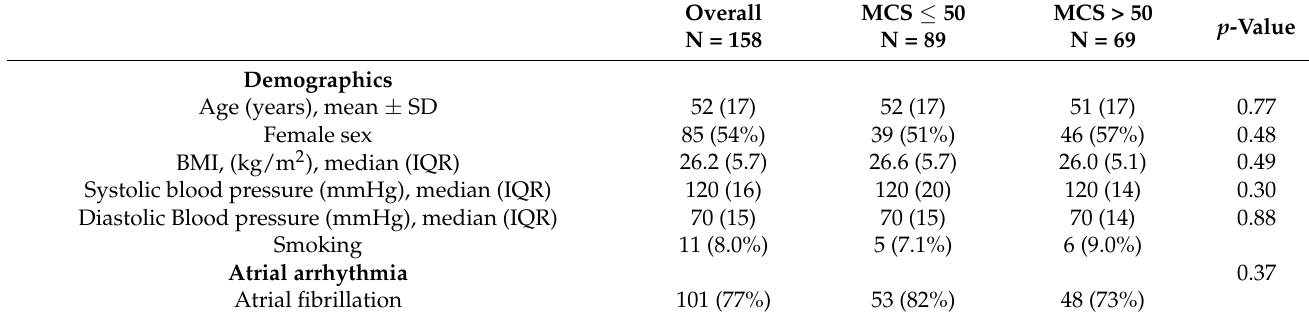
Table 3. Descriptive and clinical characteristics by mental component summary of SF-36 Health